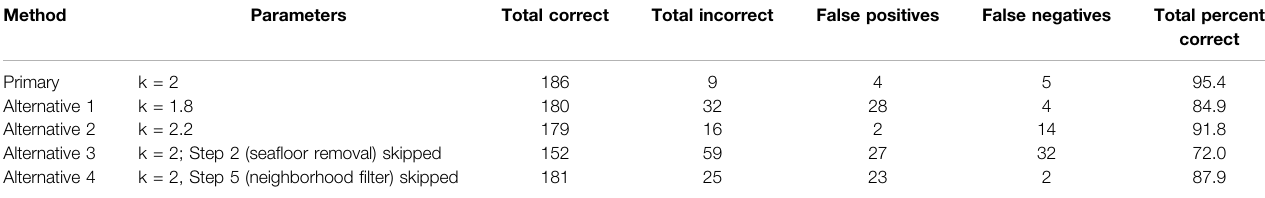
TABLE 2 | Results of total correct classi fi cations using the primary and alternative processing steps. The total correct are the total number of either true seep detections or true negatives out of 187 lines tested. Total numbers of correct and incorrect may be more than 187 due to false positives or due to a seep being classi fi ed twice due to being split between the MSR A /MSR B transition. False positives are seeps features that were classi fi ed outside of the known seep location. False negatives are cases where no seeps were detected ona linewhere the known seep waspresent. Total percent correct is based on the total number ofcorrect detections divided bythe total ofcorrect and incorrect.